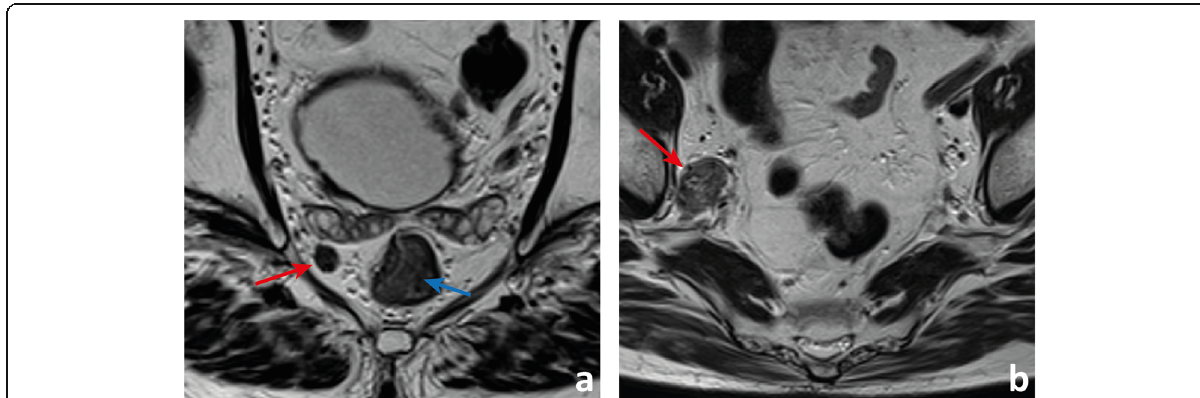
irregularly contoured, heterogeneous lymphadenopathy was found in the obturator space of the right lateral pelvic sidewall. The patient was selected for chemoradiation therapy